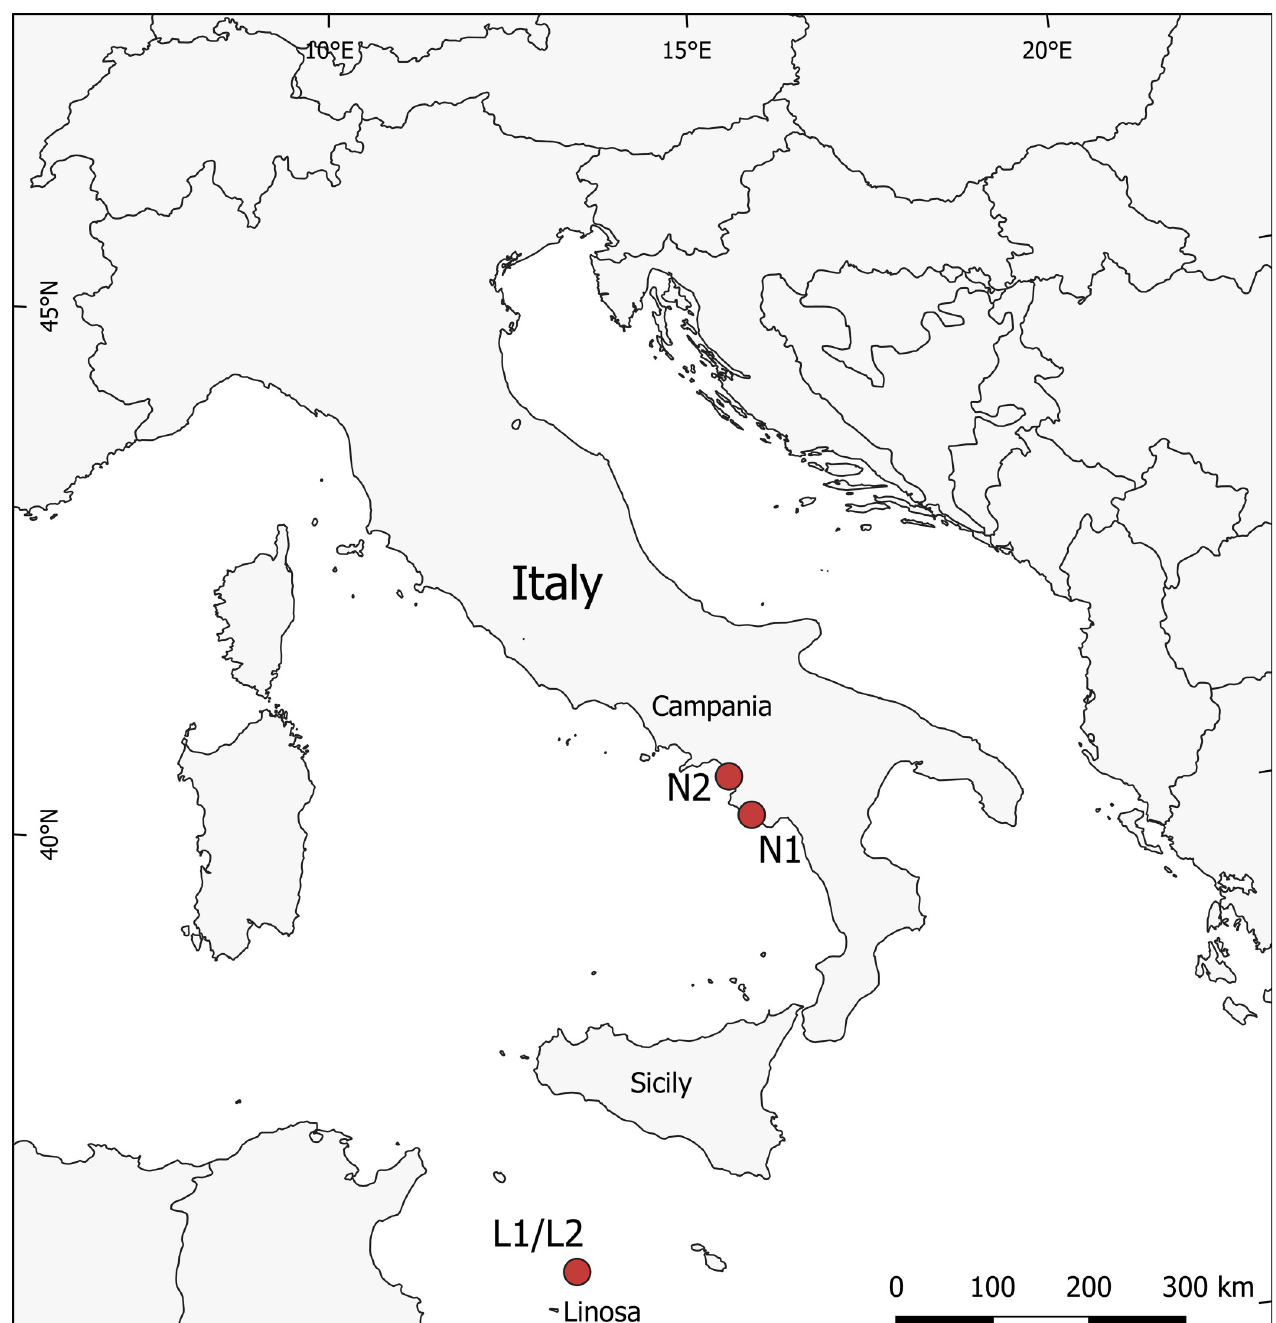
Fig 1. Map of the nesting beaches. L1 and L2, Linosa; N1, Ascea Marina; N2, Eboli. https://doi.org/10.1371/journal.pone.0268345.g001 transferred into sterile tubes. DNA extraction was carried out using 1 g of sand, yolk egg, the gastrointestinal tract of hatchling and pipping sea turtles and small fragments of the eggshells (both from hatched and unhatched eggs), following the protocols previously reported [22] with minor modifications. Specifically, the samples of sand, yolk egg and the gastrointestinal